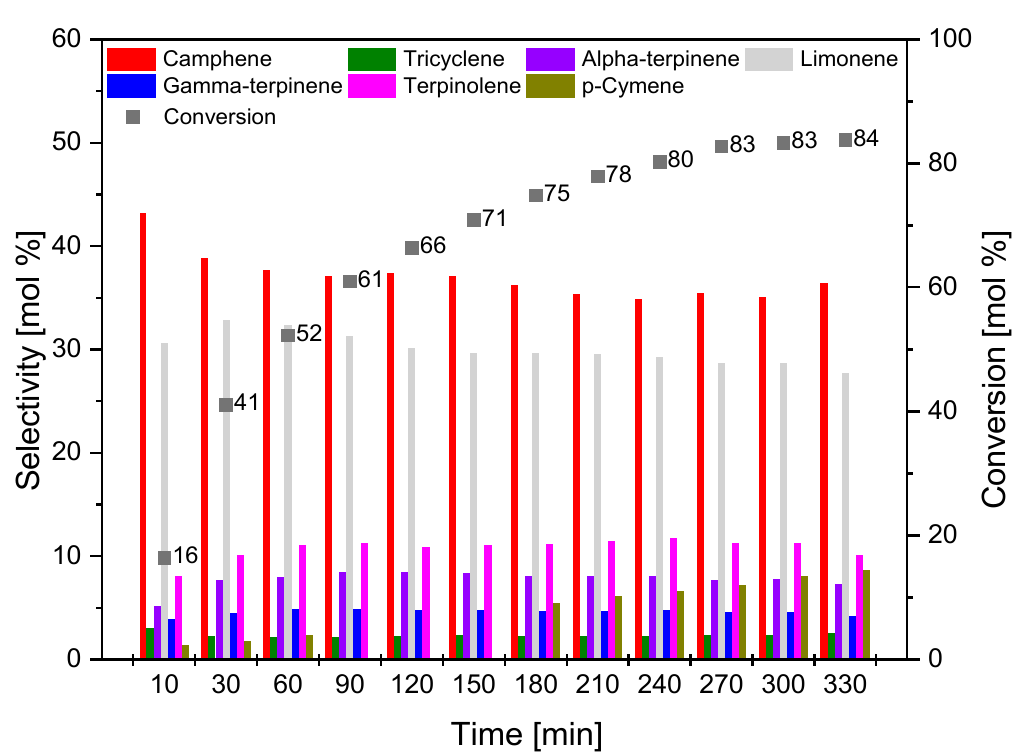
Figure 13. Influence of time on the selectivity of the main products and conversion of organic raw material (alpha-pinene) for O_AC sample.